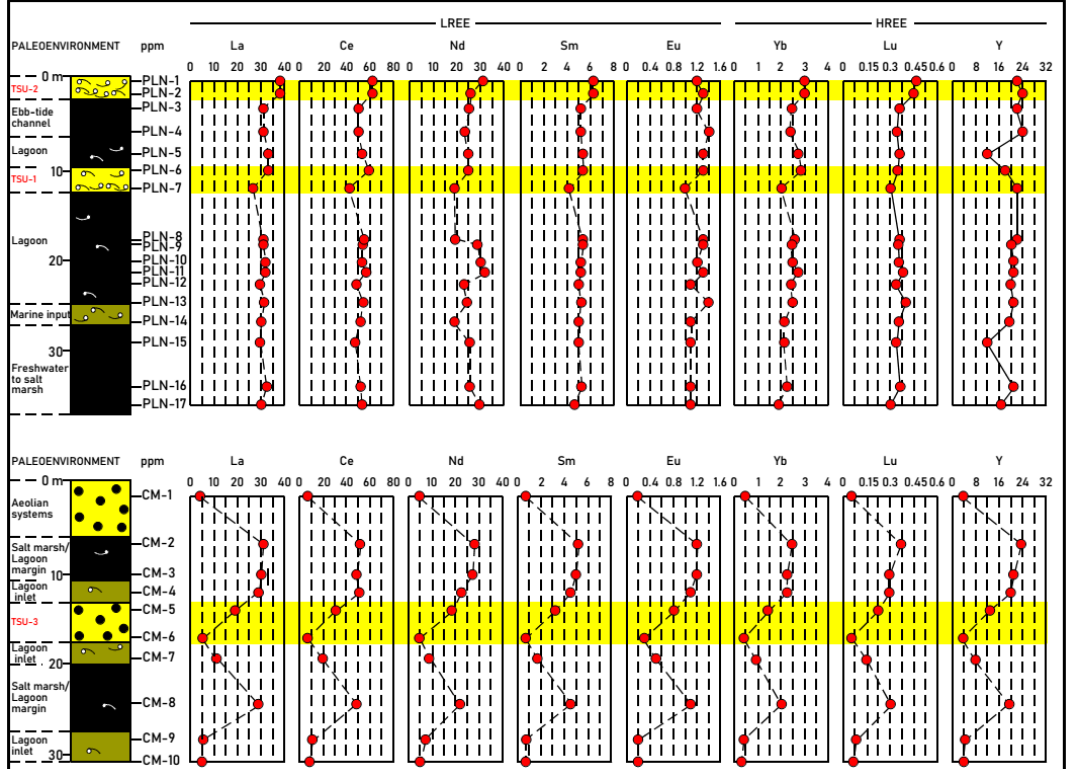
Figure 4. Vertical variations (in ppm) of the light rare-earth elements (LREE) and heavy rare-earth elements (HREE). The detection limits are 0.5 ppm (La), 3 ppm (Ce), 5 ppm (Nd), 0.1 ppm (Sm), 0.2 ppm (Eu), 0.2 ppm (Yb), 0.05 ppm (Lu) and 1 ppm (Y). Mineralogical Changes